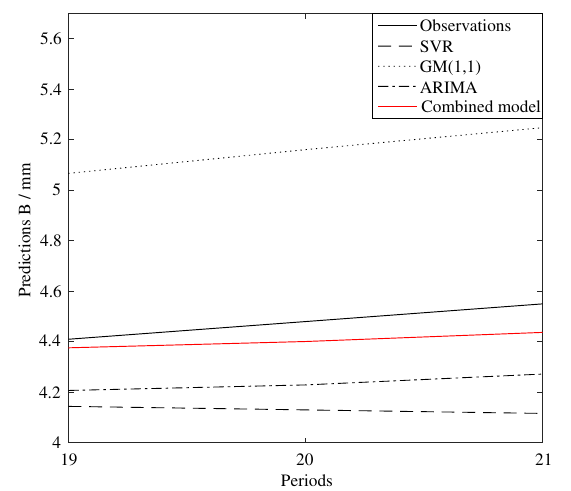
Fig. 4 Predictions B of each model. Predictive value B is predicted by the three single models and combined model when the fitting data contains gross error (fifth and tenth observations were changed to 6 and 8 mm respectively). According to the predictions B of single model and combined model, and the observations, we connect the respective values through the broken line, which can form the most direct contrast